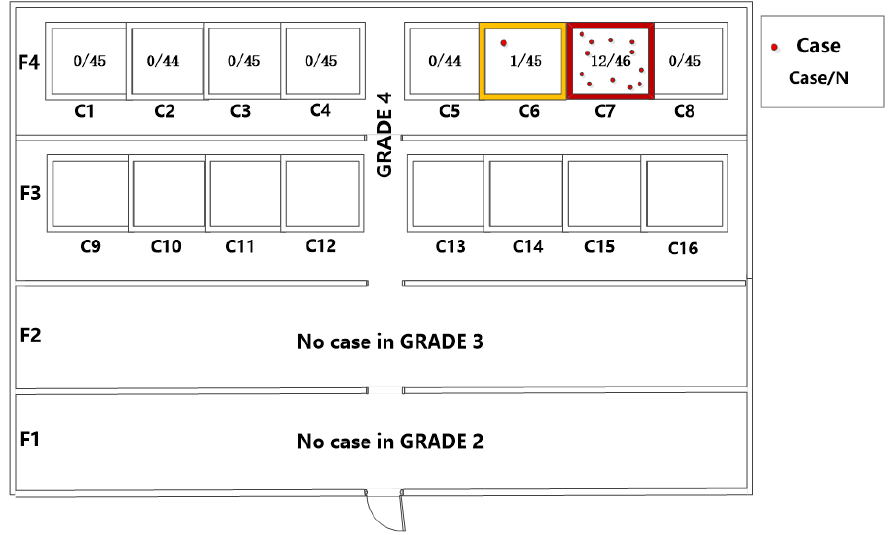
Figure 2. Classroom distribution of reported cases.